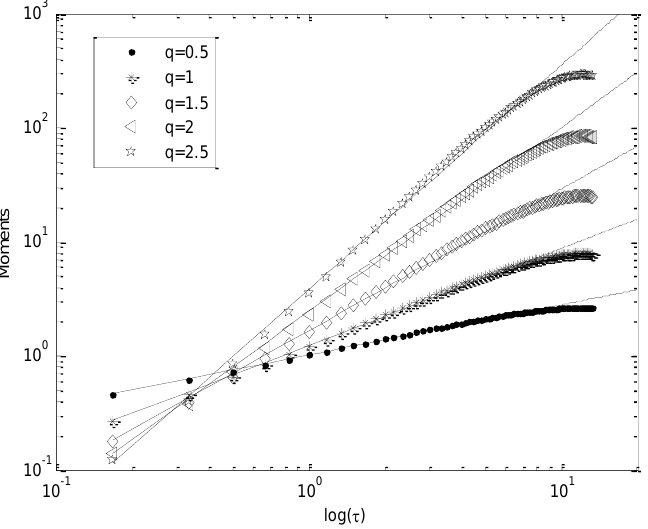
Figure 4. Scaling of the structure functions in log–log plot for moments of order 0.5, 1, 1.5, 2, and 2.5 for time series A.